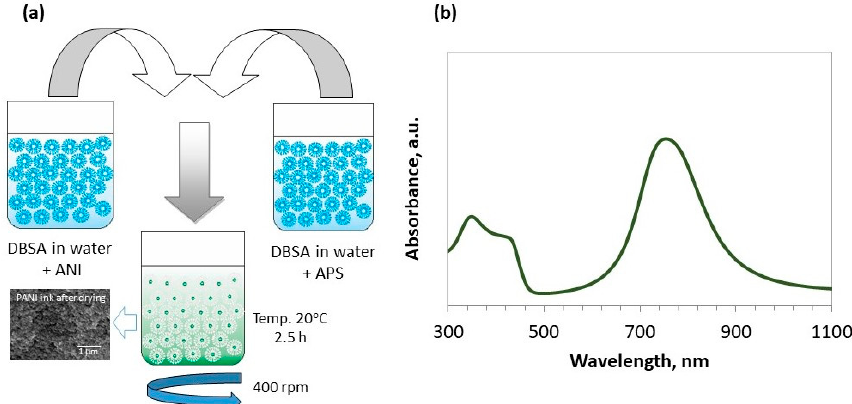
Figure 1. Synthesis of polyaniline. PANI is prepared in an aqueous medium with surfactant and using ammonium persulfate as an oxidizing agent ( a ). The UV-Vis spectrum of PANI ink in water ( b